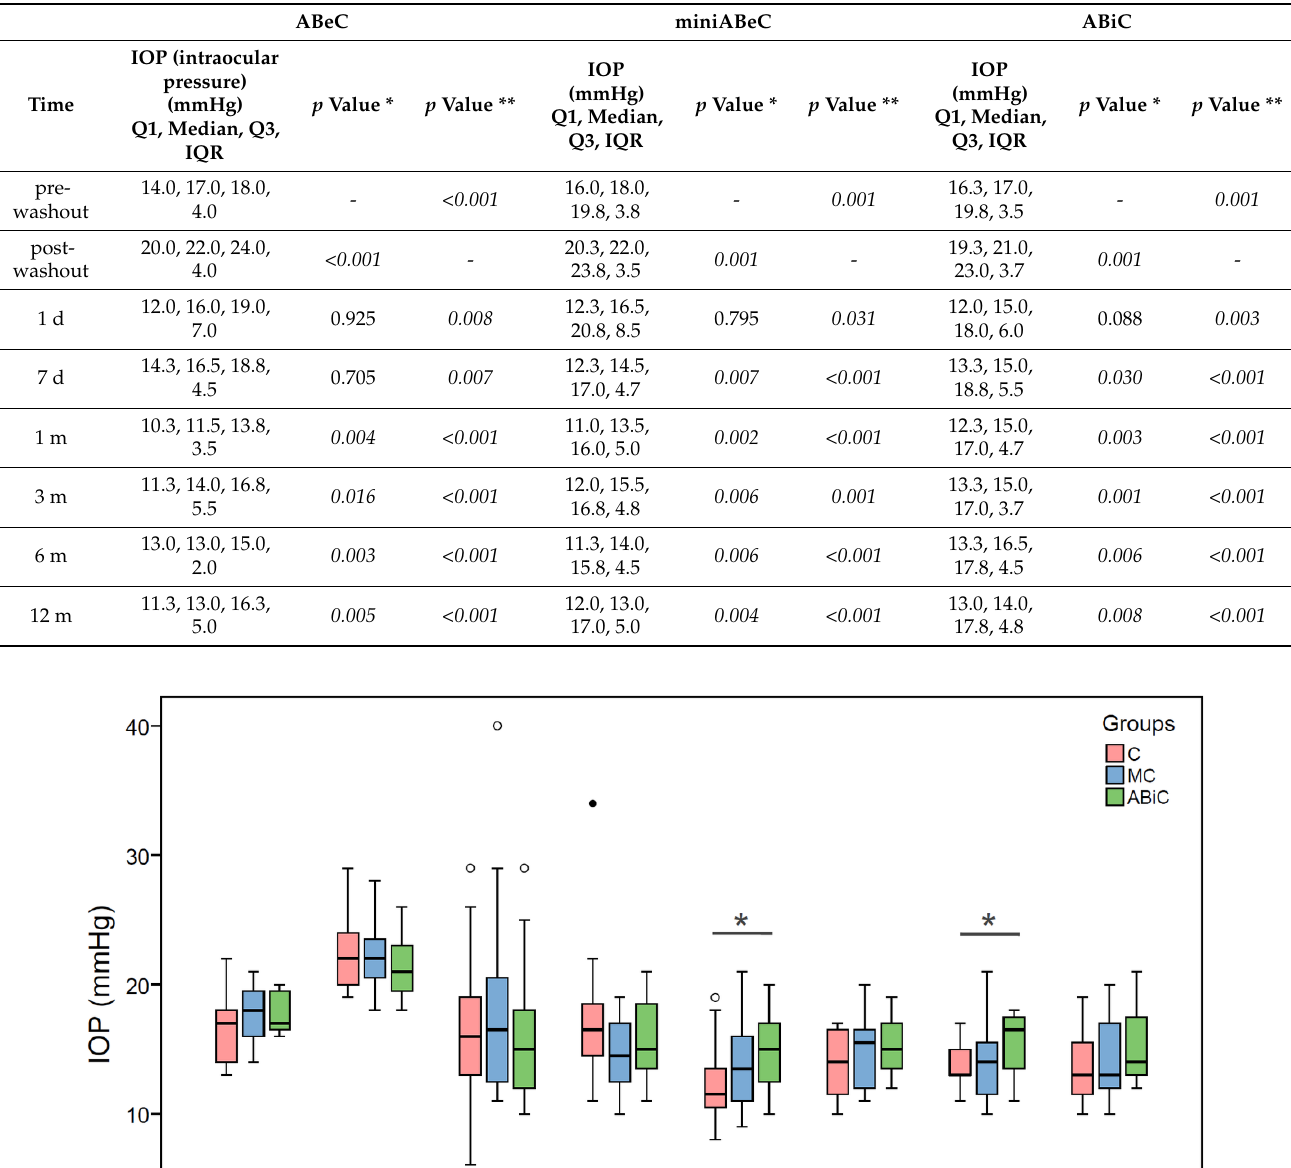
Table 2. First quartiles (Q1), medians, third quartiles (Q3) and interquartile ranges (IQRs) of IOP at each time stage before and after surgery in three groups of patients: ab externo canaloplasty (ABeC), minicanaloplasty (miniABeC) and ab interno canaloplasty (ABiC). p value * and p value ** correspond to the results of the Wilcoxon signed-rank tests between particular study stages and the pre-washout or post-washout stages, respectively. All patients in each group completed a 12-month follow-up. Italicized values indicate p < 0.05.